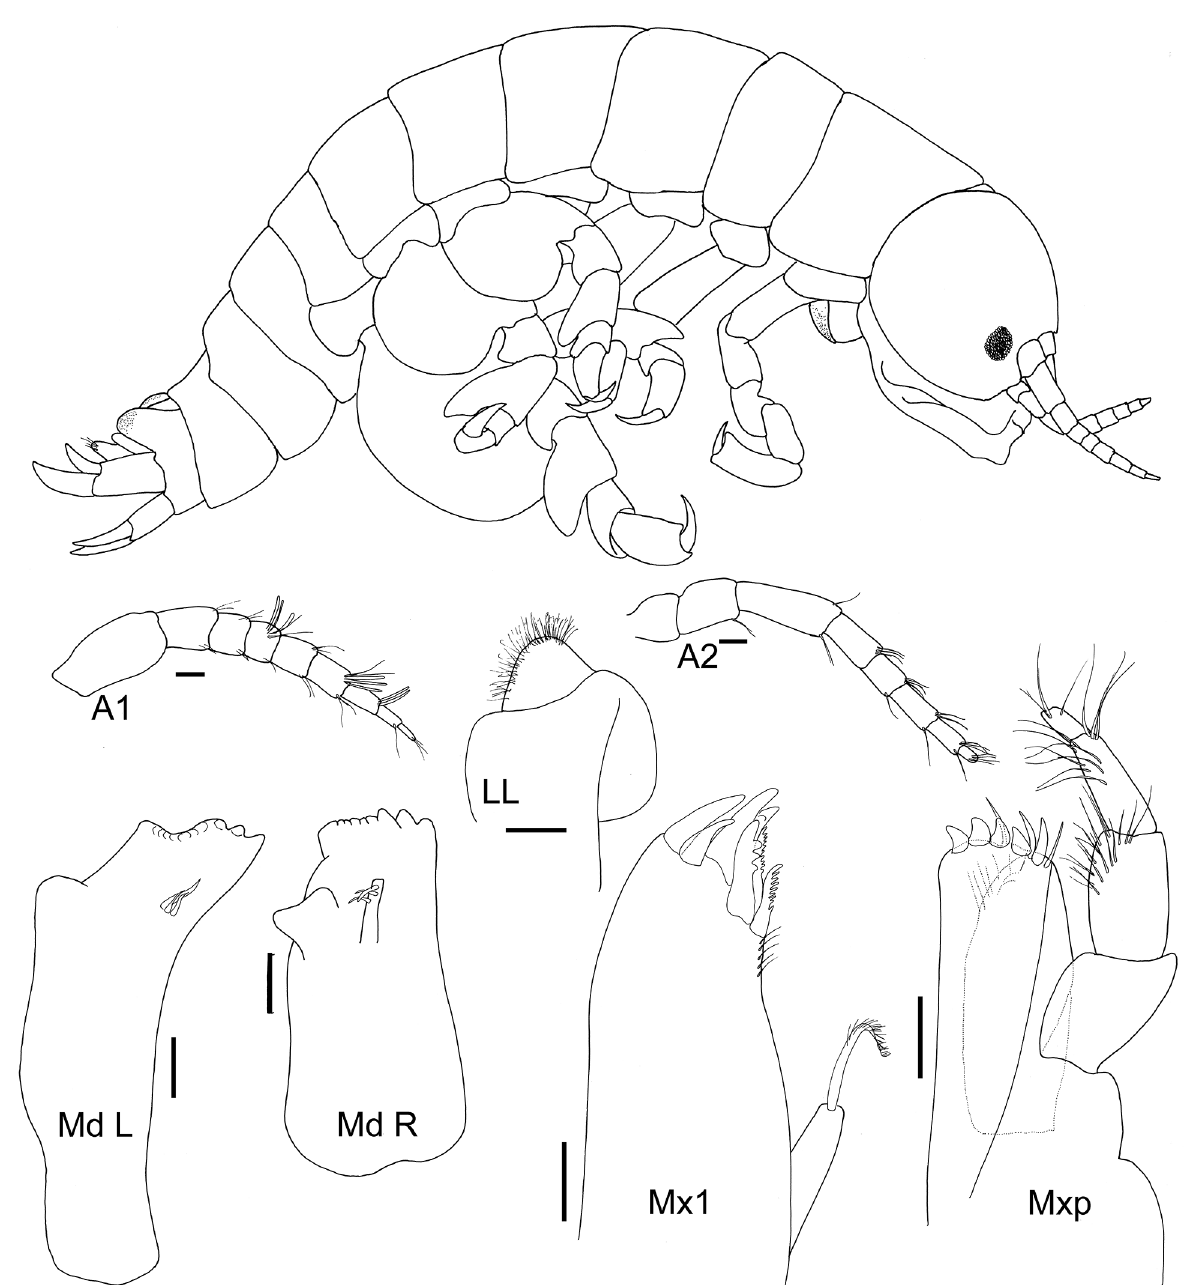
Figure 1. Bircenna hinojosai sp. nov. Holotype female, 6 mm, AM P.100648, Bicheno, Tasmania, Australia. Scale bars: 0.1